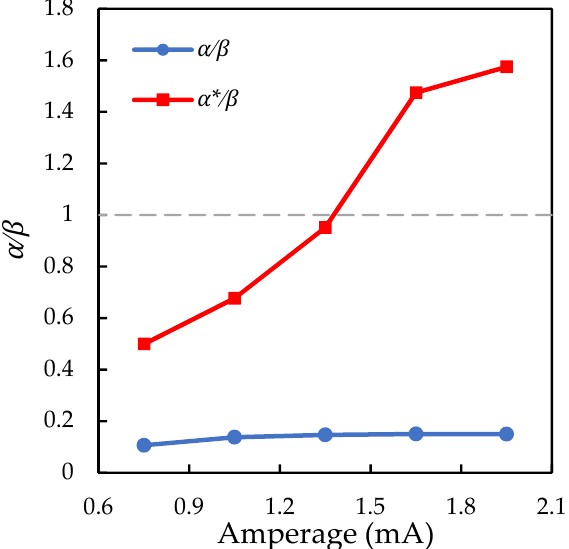
Figure 5. Ratio of the horizontal to vertical electric field gradient α / β and the ratio α ∗ / β included in the left part of the inequality (2), depending on the discharge current. When (cid:2009) (cid:2010)⁄ < 1, as follows from the conditions (1) and (2), for the lateral stability of the vertical configuration of two identical particles, in addition to the external confine- ment, the following conditions are required: unequal charges of particles ( (cid:1843) (cid:2869) (cid:1843) (cid:2870) ⁄